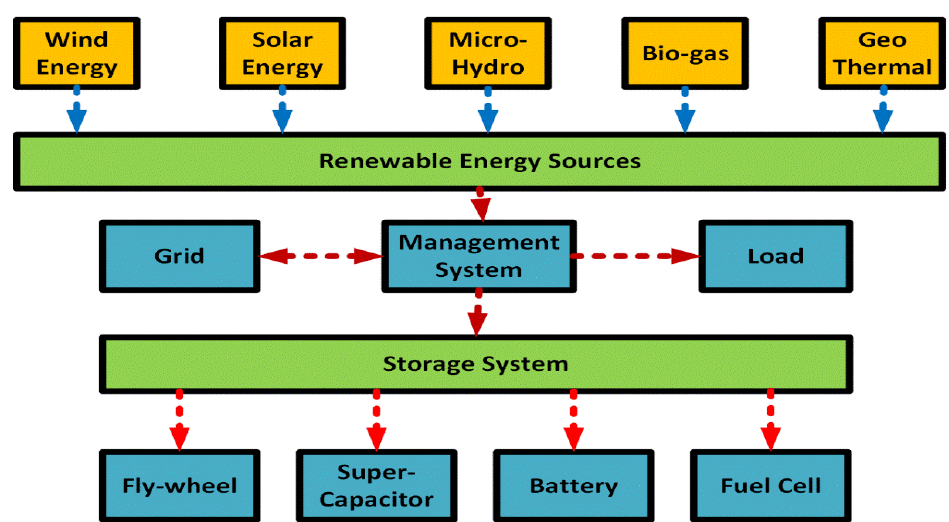
Figure 12. Possible combination of HRES systems.